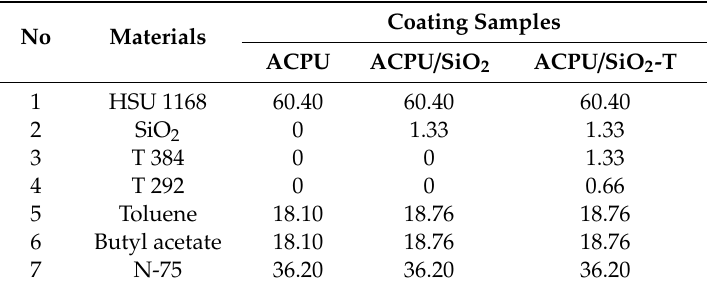
Table 1. Weight ratios of components in coating